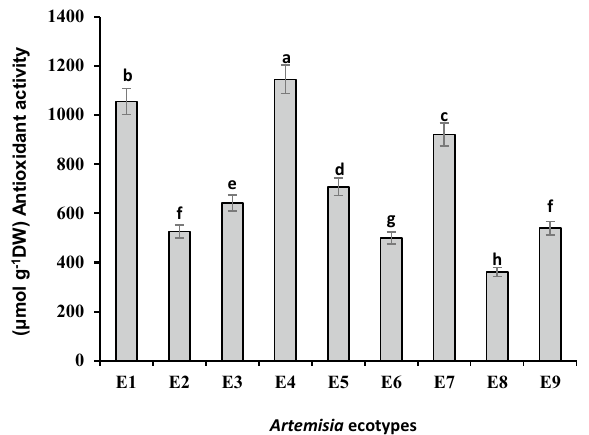
Figure 6. Comparison of mean ± standard error of antioxidant activity by FRAP method. E1: A.tournefortiana (Kerman province), E2: A.tournefortiana (North Khorasan province), E3: A.tournefortiana (West Azerbaijan province), E4: A.khorassanica (South Khorasan province), E5: A.khorassanica (North Khorasan province), E6: A.khorassanica (Semnan province), E7: A.haussknechtii (Kohgiluyeh and Boyer-Ahmad province), E8: A.haussknechtii (Isfahan province), E9: A.haussknechtii (Chaharmahal and Bakhtiari